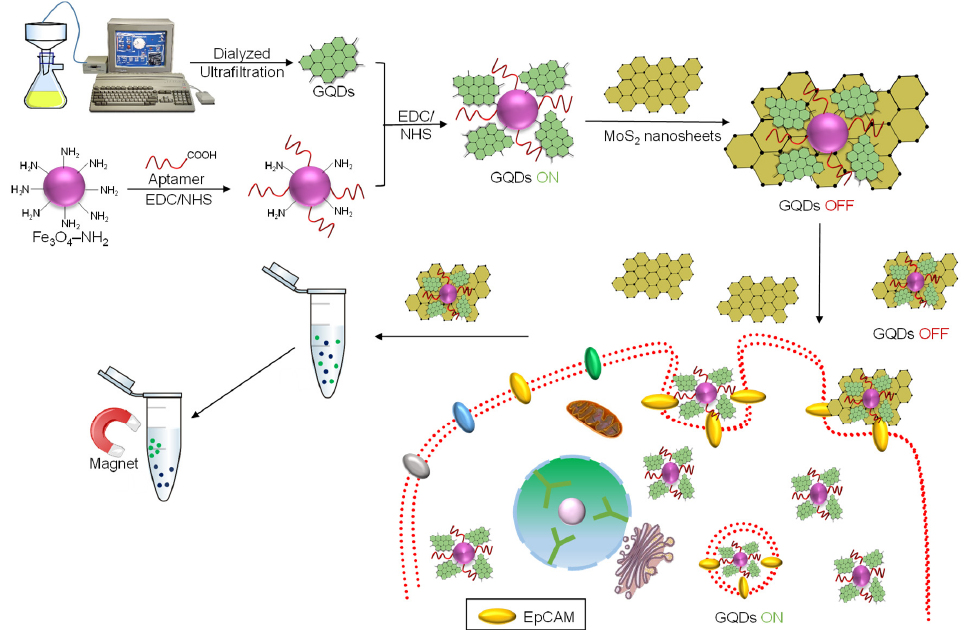
Figure 3. The detection principle of the aptamer / Fe 3 O 4 / GQDs / MoS 2 -based nanosurface energy transfer biosensor for sensing circulating tumor cells (CTCs).